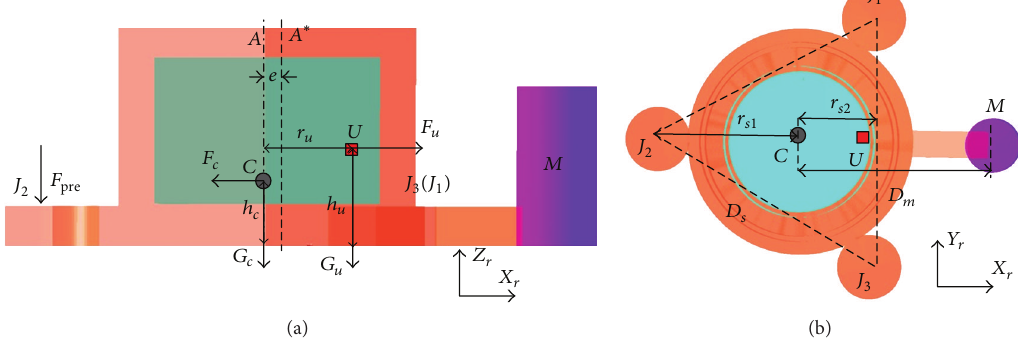
Figure 3: Forces acting on the system at the steady state when no balancer is considered: front view (a); top view (b).